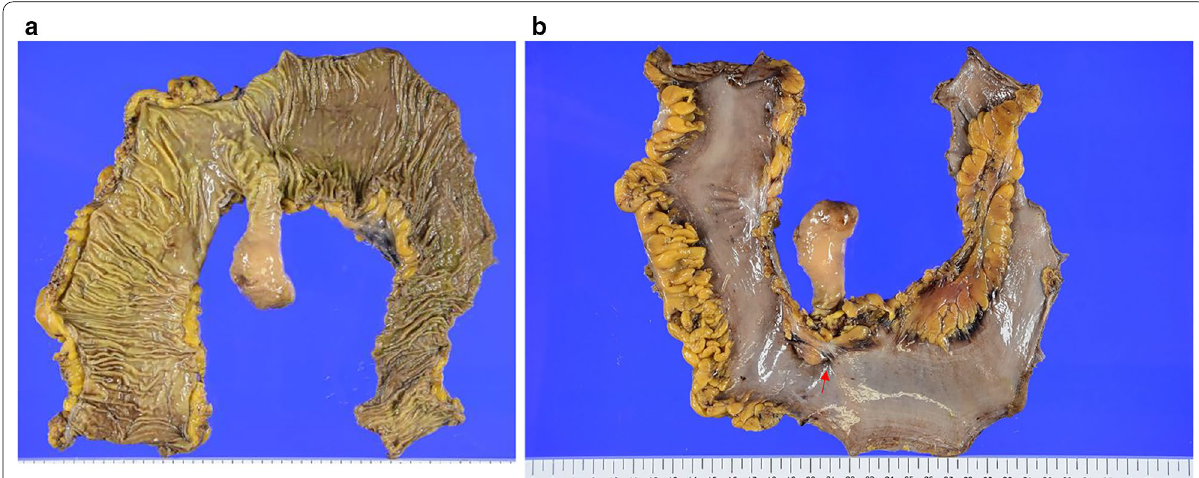
Fig. 2 Macroscopic findings from the resected specimen. a A pedunculated 38-mm mass with a club-shaped apex was found in the ileum approximately 30 cm from the terminal end. b An excavation was observed on the serous surface (indicated by the red arrow)